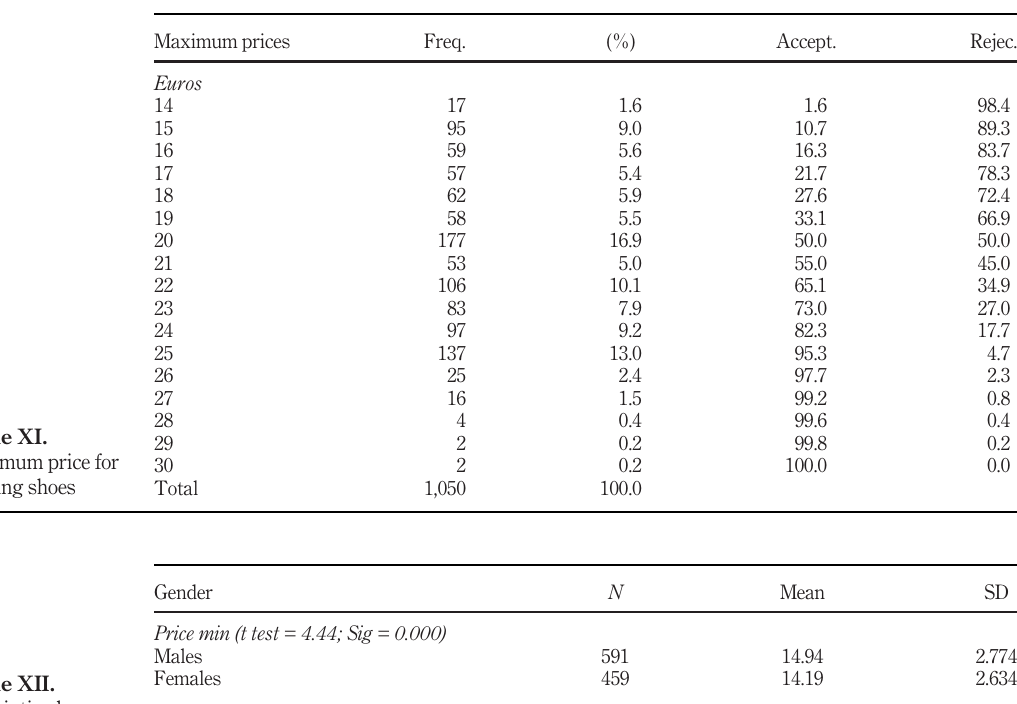
Table X. Minimum price for running shoes